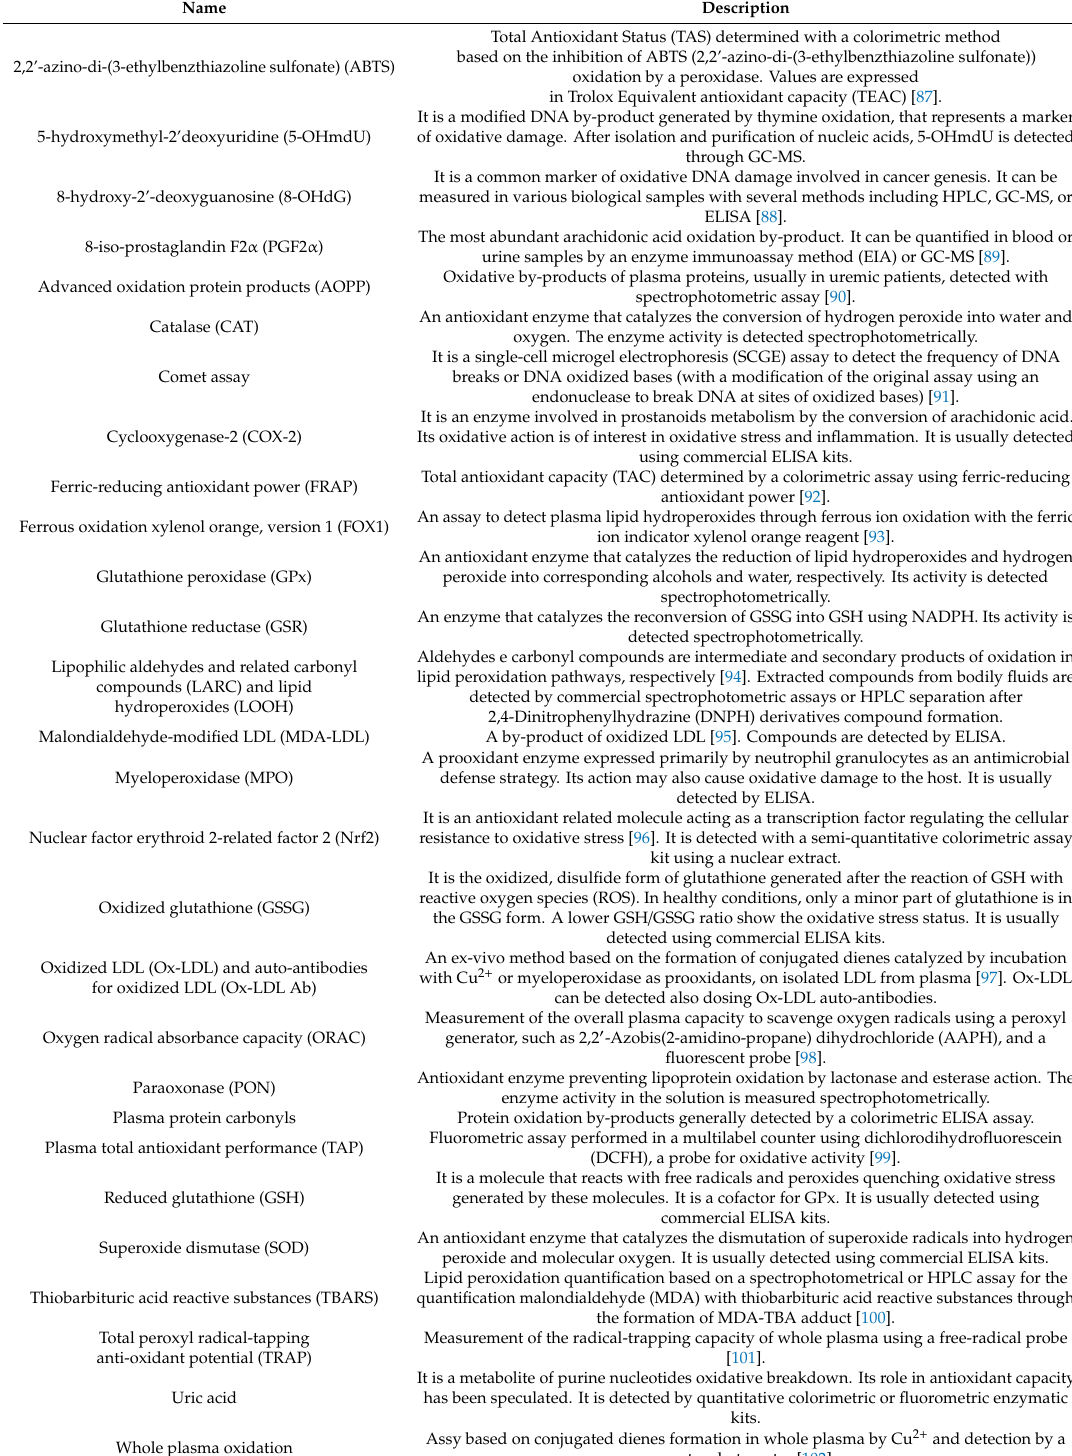
Table 2. Biomarkers for antioxidant capacity and oxidative